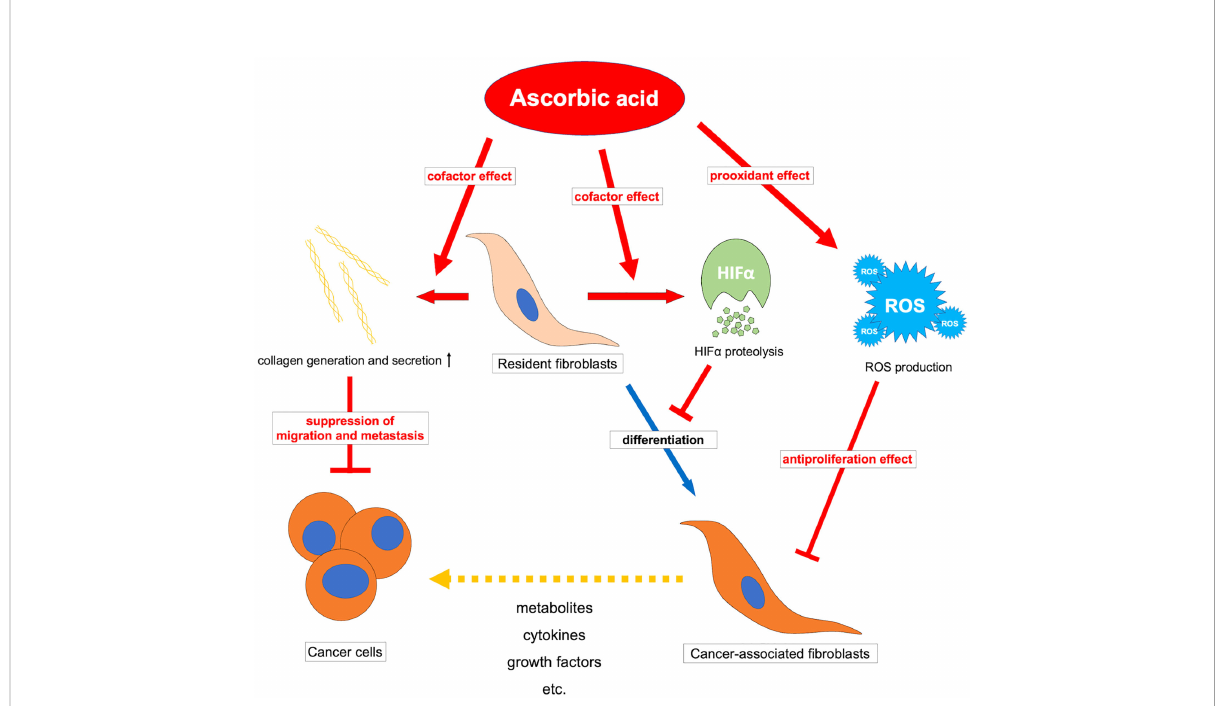
FIGURE 3 Overview of the antitumor effects of ascorbic acid on cancer-associated fi broblasts. ROS, reactive oxygen species; HIF a , hypoxia-inducible